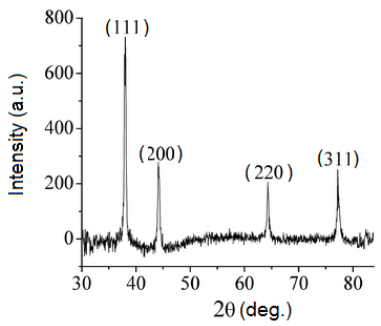
Figure 4. X-Ray Diffraction (XRD) pattern of silver nanoparticles.